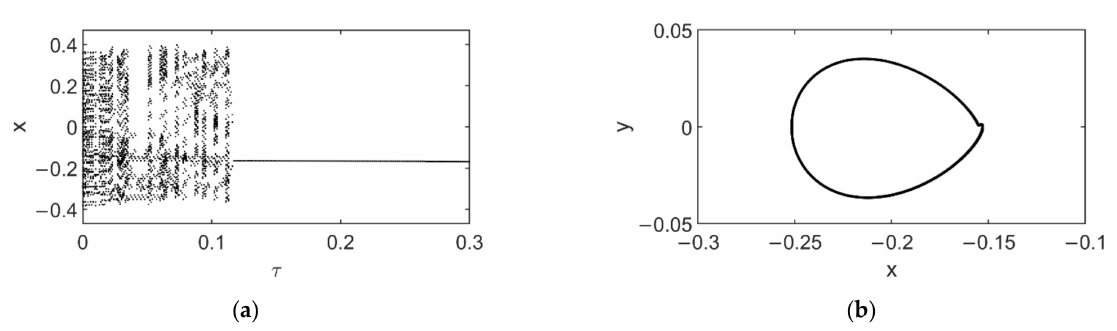
Figure 10. Dynamic behavior of the delayed system (39) when g p = 0.2 and V AC = 0.16 V ( a ) Bifurcation with τ in Poinc á re map ( b ) Phase map when τ =